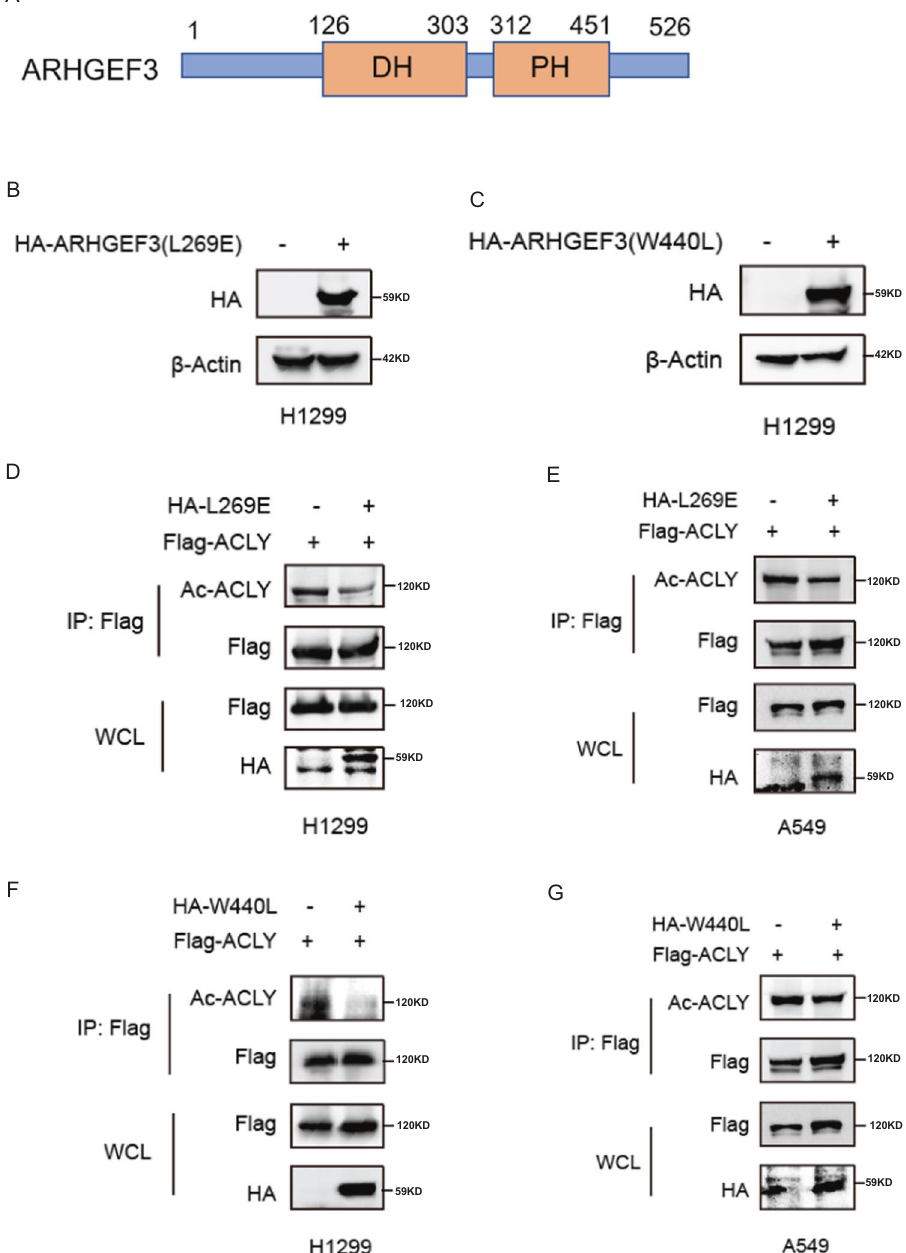
Fig. 6 ARHGEF3 regulates ACLY stability independently of its GEF activity. A Structural diagram of ARHGEF3. B , C Western blot was used to detect the expression effect of ARHGEF3-L269E and W440L. D , E Western blot was used to detect the effect of ARHGEF3-L269E on ACLY acetylation. F , G Western blot was used to detect the effect of ARHGEF3-W440L on ACLY